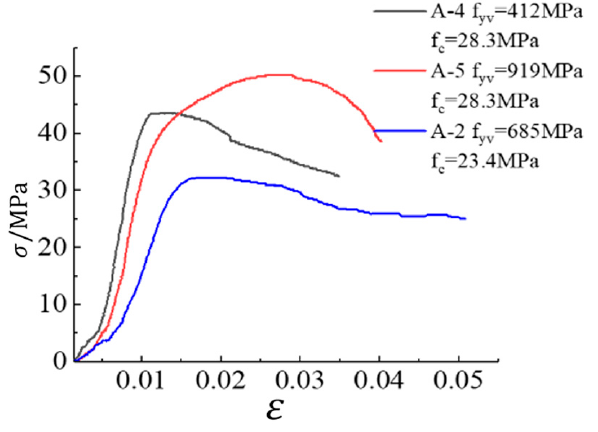
Figure 6. Influence of stirrup strength (Specimen of four-spiral composite stirrup).